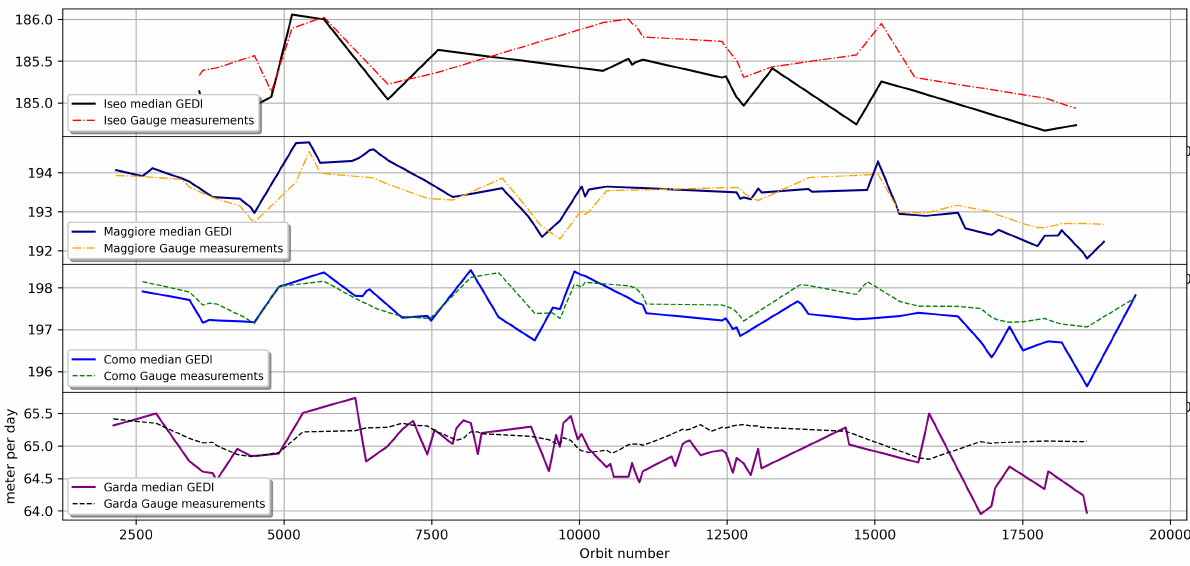
Figure 4. The Four lakes GEDI Median and the gauge measurement changes over the course of orbit number from the period 2019/06 – 2022/06